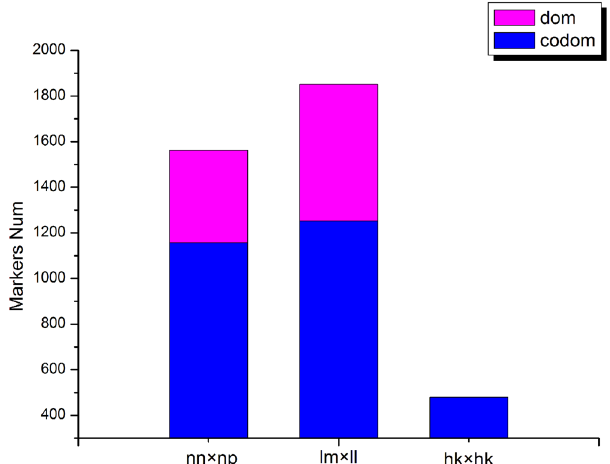
Figure 2. Number of markers for each segregation pattern. The x-axes means marker type and y-axes means marker number.